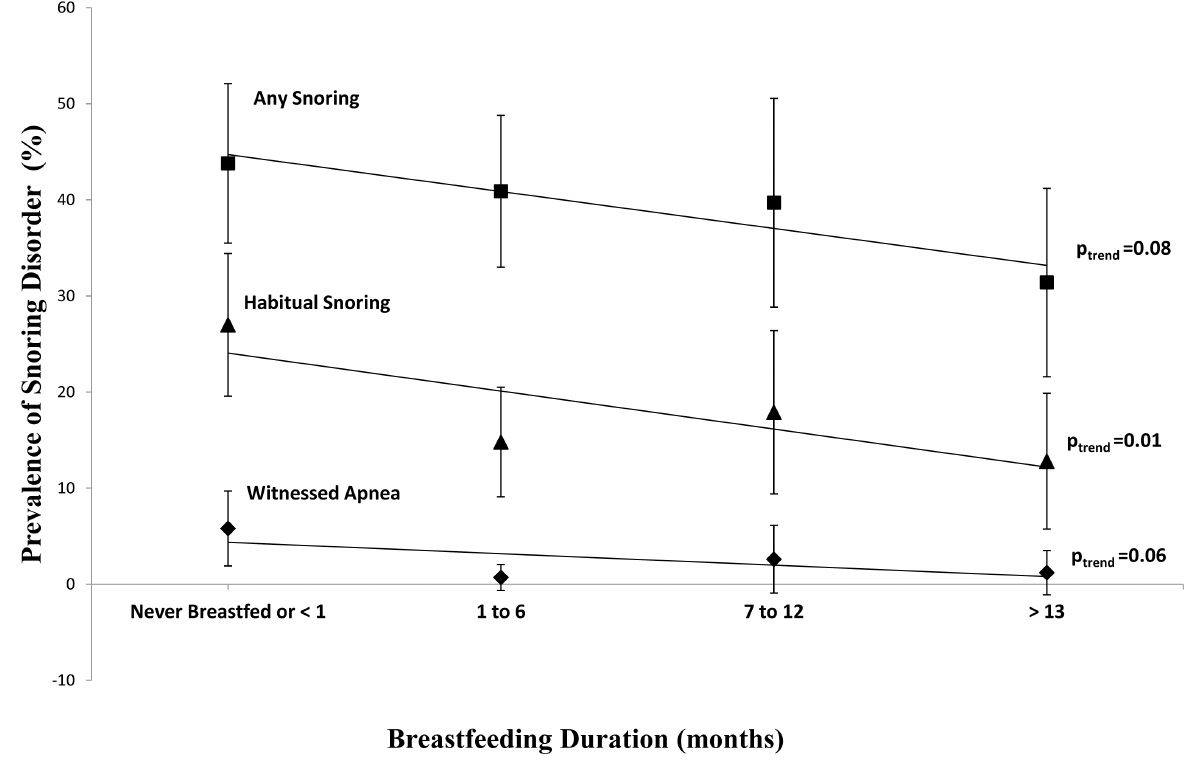
Figure 2. Associations between Breastfeeding Duration and Snoring outcomes. CAPS cohort N=450. Comparing the prevalence of different parent reported sleep disordered breathing at age 8 against the amount of breastfeeding recorded during the first year of life to see whether breastfeeding has a dose-response relationship with protection against later snoring or sleep apnea. P-values indicate significance of a linear trend and the error bars are 95% confidence limits for the proportions.